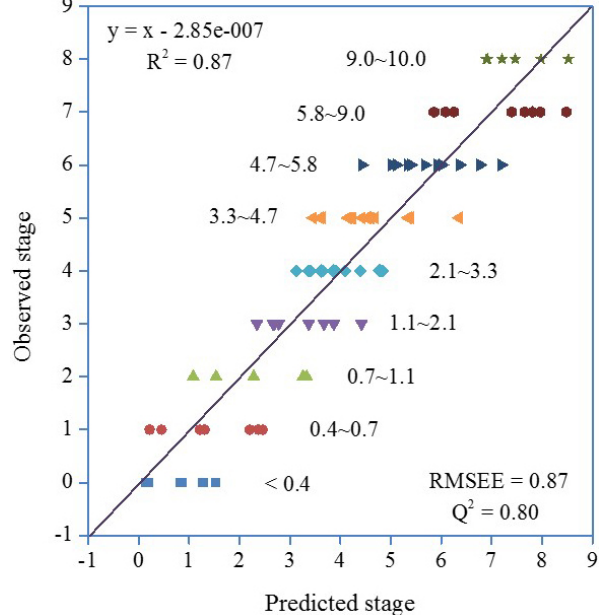
Figure 6. Measured and predicted total PAHs in all particles with sizes ranges from <0.4 to 10µm. The dashed line represents the 45 ◦